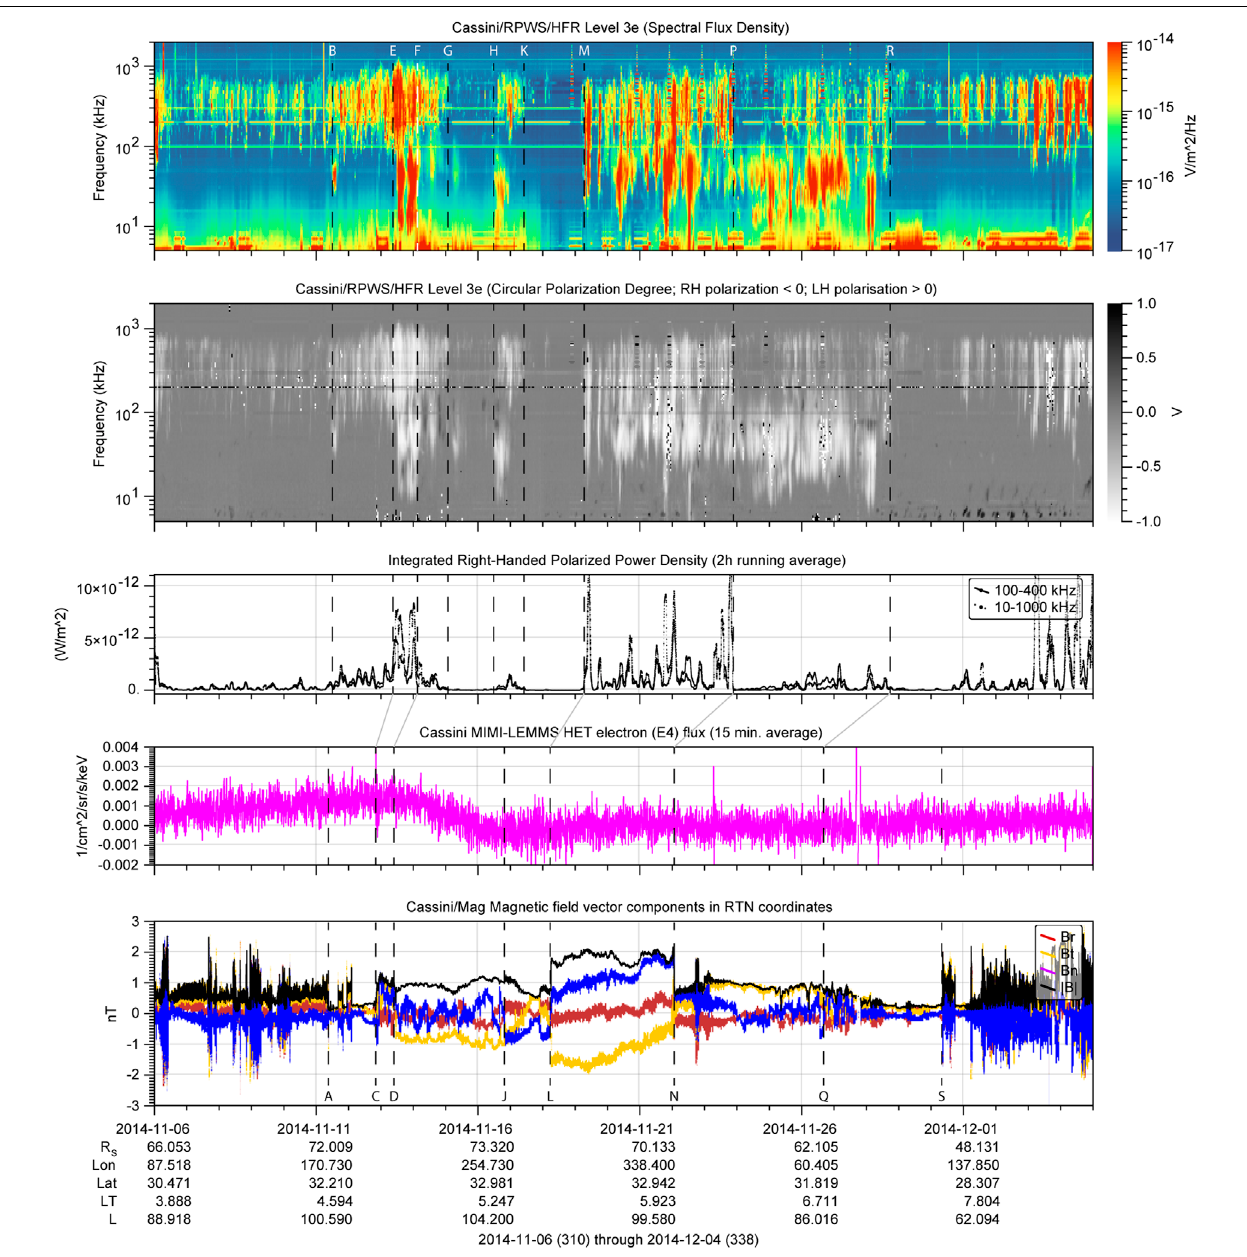
FIGURE 4 | The from top to bottom: Radio electric flux density spectrogram; Radio electric circular polarization degree spectrogram; SKR integrated flux (plain line: 100–400 kHz range; dotted line: 10–1000 kHz range), with a 2 h running average; energetic particle fluxes for electrons (magenta line) in units